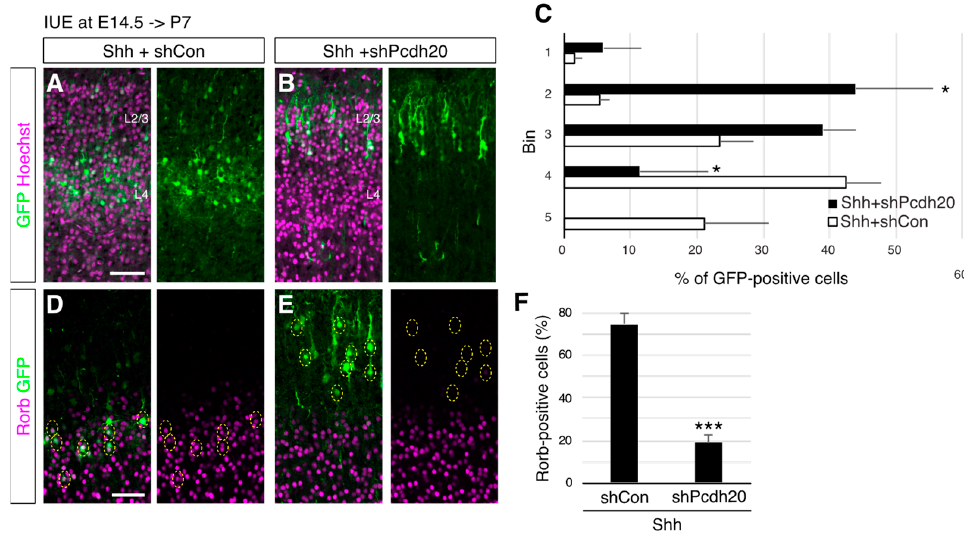
Figure 5. Shh overexpression promotes L4 fate acquisition in a cell positioning-dependent manner. Shh expression vector together with a control shRNA (Shh+shCon) or Pcdh20 shRNA vector (Shh+shPcdh20) was electroporated into E14.5 brains, and then P7 brains were analyzed. The sections were counterstained with Hoechst ( A , B ) or immunostained for Rorb ( D , E ). ( C ). Quantitative data of cell positioning are presented. The position of each GFP-positive cell relative to the total distance from the bottom of L4 to the outer edge of the cortical plate was measured, followed by sorting into 5 bins in each condition ( n = 4 for each group). ( F ). The result of quantitative analysis for Rorb is presented ( n = 4 for each group). * p < 0.05, *** p < 0.001. (Scale bars: 200 µm in ( A , D )).